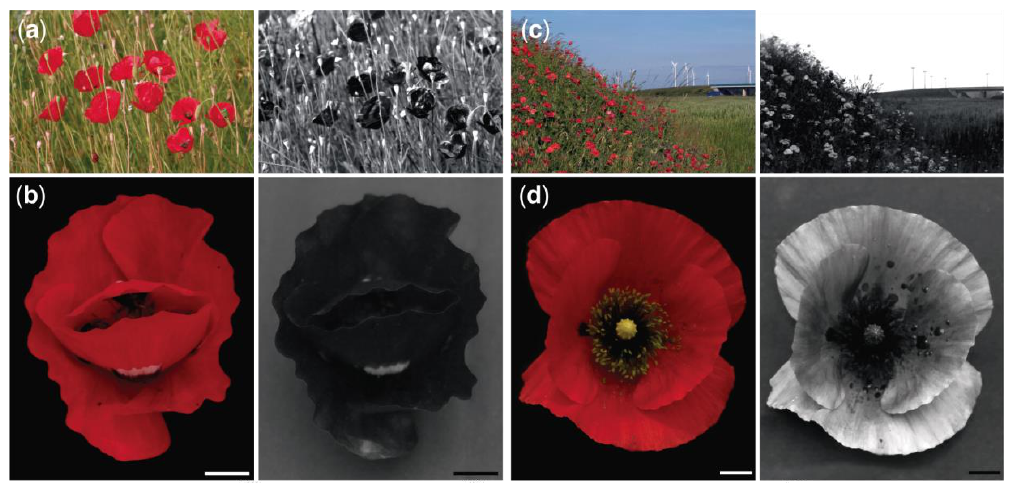
Figure 1. RGB and UV images of flowers of P. rhoeas . ( a ) A field containing flowers of P. rhoeas in the East Mediterranean. ( b ) A P. rhoeas flower collected in the East Mediterranean. ( c ) A field with P. rhoeas flowers in Central Europe. ( d ) A P. rhoeas flower collected in Central Europe. Scale bars: (b,d) 1 cm.